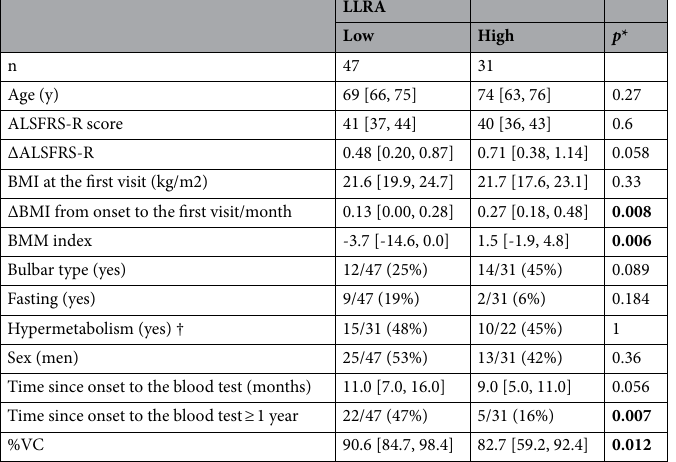
Table 3. Demographic and clinical data in relation to LLRA. Data represent the median value [interquartile range]. * p < 0.05, by Fisher’s exact test or the Mann–Whitney U test. † Hypermetabolism was defined as mREE/ LSTM ≥ 38 kcal/kg. LLRA, lipid-linked risk for ALS; ALSFRS-R, Revised Amyotrophic Lateral Functional Rating Scale; BMI, body mass index; BMM index, BMI-muscle metabolism index; VC, vital capacity. Significant values are in